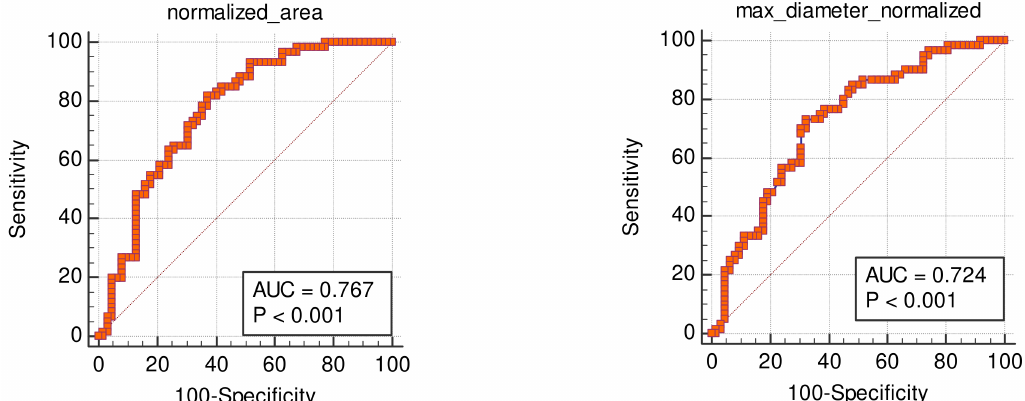
Figure 5. Normalizing the knee cross-sectional area and maximal knee diameter by dividing the measurements by the maximal femur diameter (at the level of the condyles) results in an increase in the respective